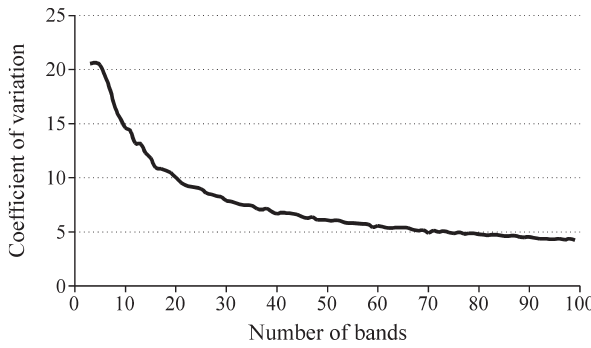
Figure 5 - Sample variance for the Sarchimor progenies and cultivars of C. arabica , derived from a bootstrap procedure after 1000 sampling, illus- trating the relationship between the mean coefficient of variation (%) and the number of